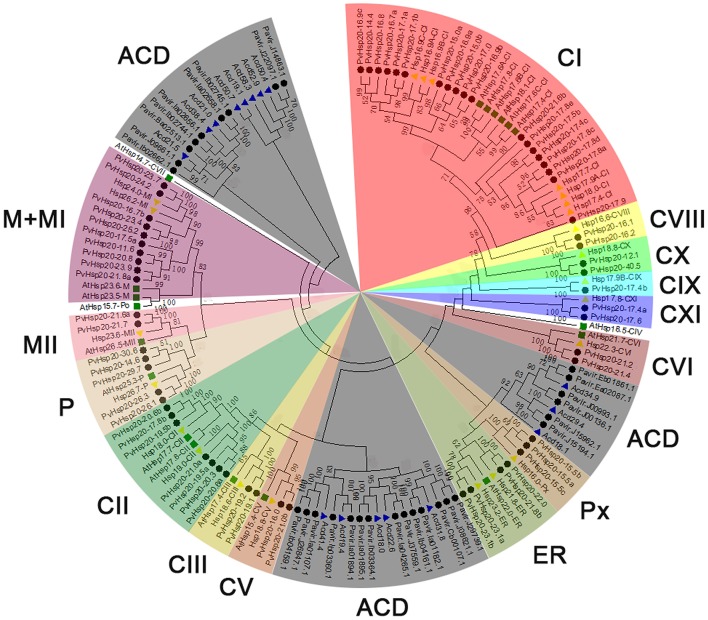
Phylogenetic pie chart of Hsp20 proteins in switchgrass, rice, and Arabidopsis. The Hsp20 proteins are used for building the phylogenetic tree via MEGA 5.0 after the alignments by ClustalX. The unrooted neighbor-joining analysis was conducted with 1,000 bootstrap replicates and p-distance method (only percentage bootstrap scores above 50% were shown in this tree). Rice, Arabidopsis, and switchgrass are Hsp20 proteins were marked with yellow triangles, green squares, and black circles, while Acds in rice were marked with blue triangles. The 15 distinct subfamilies are marked by different colors, and the Acds subgroup was colored in gray.